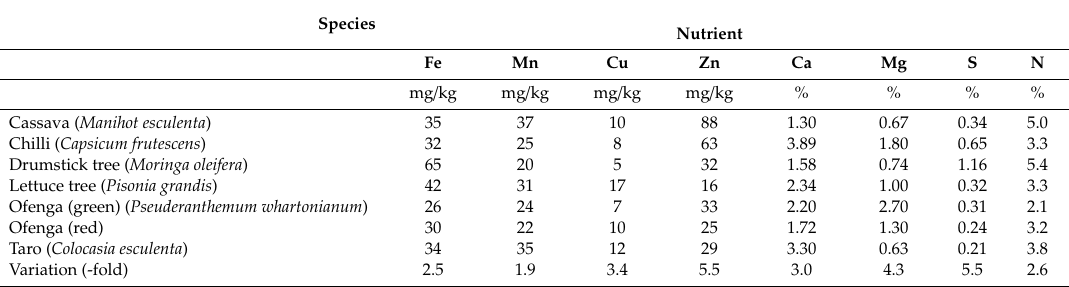
Table 2. Concentrations of macro- and micronutrients in leaves (dry weight basis) of di ff erent food plant species grown together on the same soil type at Tanaea, South Tarawa, Kiribati in August 2014.